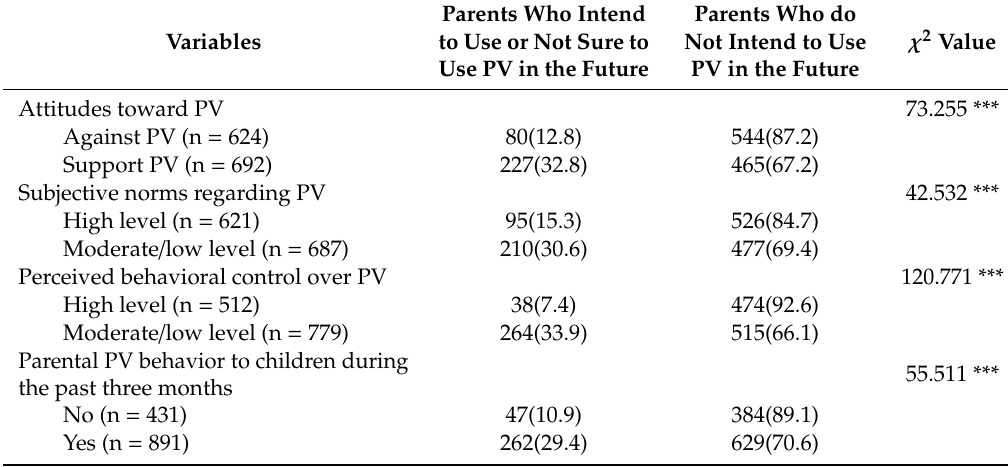
Table 2. Descriptive statistics for constructs of the theory of planned behavior (TPB) and bi-variable associations with parents’ intentions to use PV in the future. n (%).